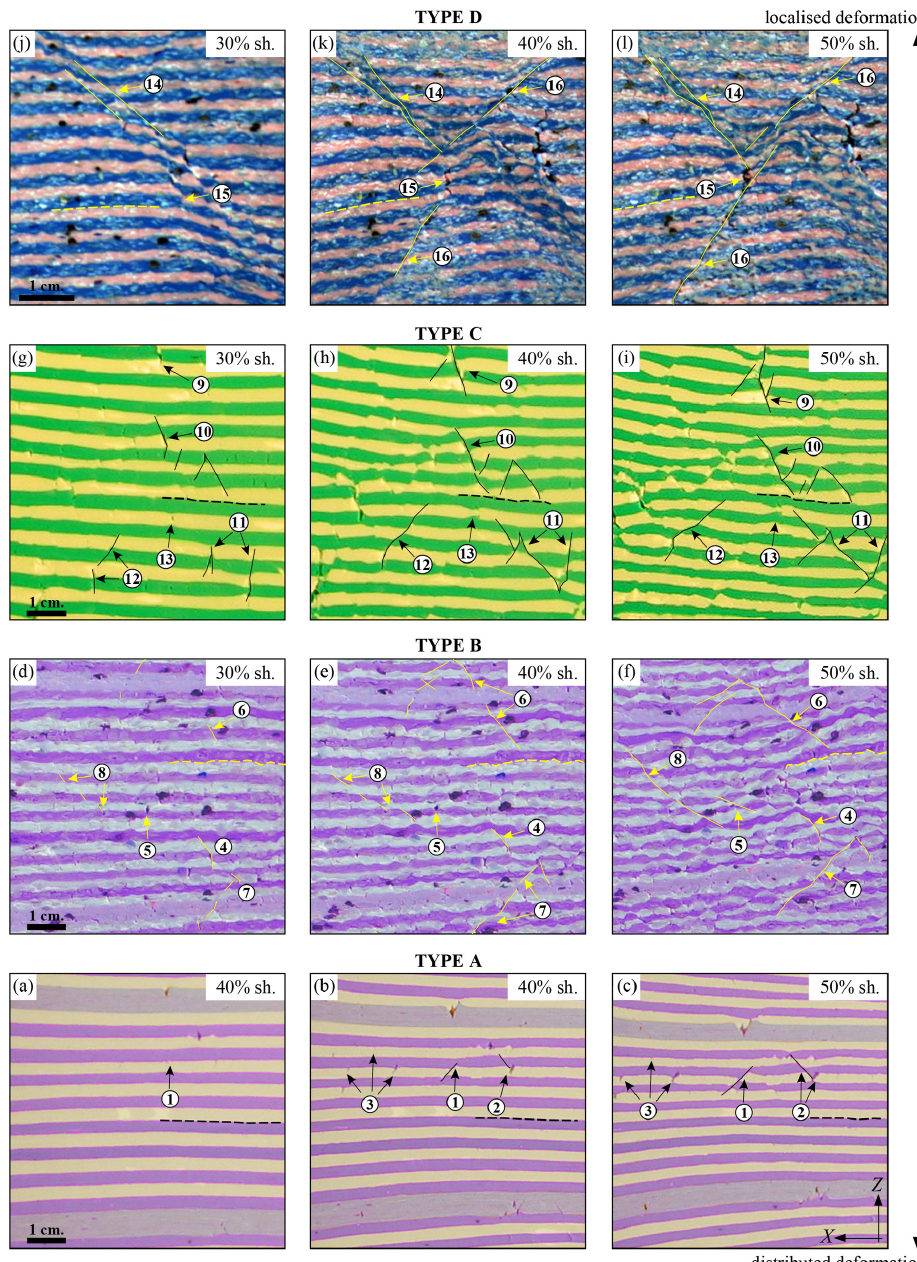
Figure 8. Detailed photographs showing the evolution of structures in the four different experiments. (a–c) Type A experiment: (1) a shear- fracture forms from a slightly pinched layer; (2) coeval development of a tension crack and a shear fracture; (3) tension cracks keep forming until ∼ 40% shortening. (d–f) Type B experiment: (4) mixed-mode fracture with associated drag folds. The propagation rate was very low due to plastic deformation at fracture tips; (5) tension crack that collapsed and gave rise to a shear fracture; (6) in-plane shear fracture with enhanced propagation at one of the tips; (7, 8) linkage of fracture segments produced larger fractures with heterogeneous displacements. (g–i) Type C experiment: (9) nucleation and propagation of a tension crack that evolved to a mixed-shear mode fracture; (10) progressive enlargement of individual fractures as a result of progressive tip-line propagation and linkage with the nearest fracture segments; (11) nucle- ation of conjugate shear fractures from tension cracks, resulting in sharp fracture segments; (12) relatively long shear fracture that formed by linkage of a tension crack and a shear fracture; (13) small tension crack that evolved to form a heterogeneous asymmetric boudinage-like structure. (j–l) Type D experiment: (14) formation of two parallel dextral fractures that propagate and join, and their lower tip ends at a larger conjugate fracture; (15) development of a tension crack at the intersection between large shear fractures; (16) a very large sinistral fracture with zigzag geometry forms by segment linkage from side to side of the model. Solid lines represent fractures, while dashed lines indicate